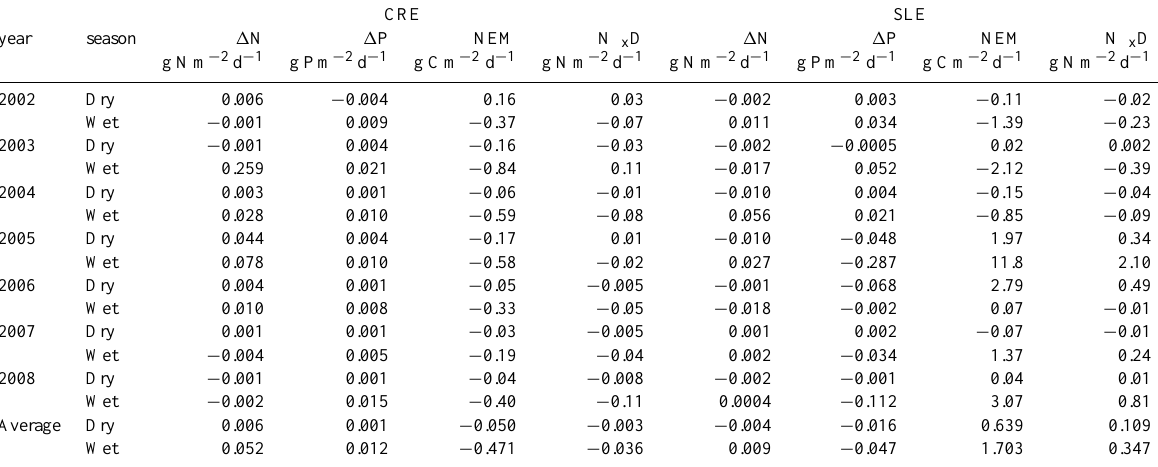
Table 4. Rates of internal dissolved CNP turnover resulting from seasonal DIN and DIP budgets of CRE and SLE from 2002 to 2008. Net internal production or consumption of DIN and DIP were derived through a budgeting process that incorporates water, salt, and